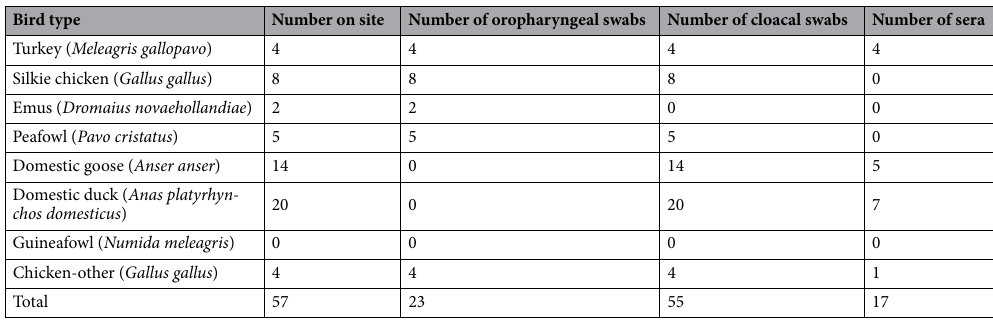
Table 1. List of samples for virological and serological analysis collected by CFIA on 17 December 2021 from different species of captive birds still present at the farm.